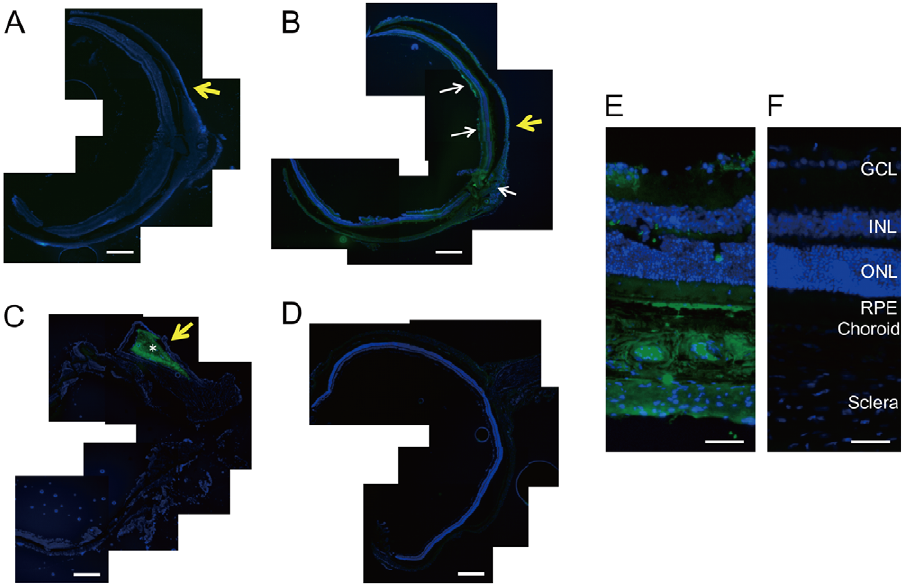
Figure 3. Immunohistochemistry of vasohibin-1 after device implantation. The immunohistochemistry results of vasohibin-1 after NVDD, 10VDD, and pellet implantation are shown. No immunoreactivity was observed after NVDD transplantation (A) and negative control without first antibody (D). 10VDD shows vasohibin-1 immunoreactivity at the device implant area (B). White arrows show the immunoreactivity in the retina and optic nerve at low magnification. Diffuse immunoreactivity was observed in the sclera, choroid, RPE, and retina at greater magnification (E). Strong immunoreactivity was observed in the ganglion cell layer (GCL) and retinal pigment epithelium (RPE), as well as in the sclera and choroid. INL and ONL indicate the inner and outer nuclear layers. These results were not observed in the NVDD group (A) or the negative controls (D and F). Strong immunoreactivity was observed in the pellet (asterisk) and in the tissues surrounding the implanted pellet (C). Yellow arrows indicate the positions where devices or pellets were placed. Devices were removed before sectioning, but pellets were not removed before sectioning. Bars: 200 m m (A–D), and 50 m m (E, F).